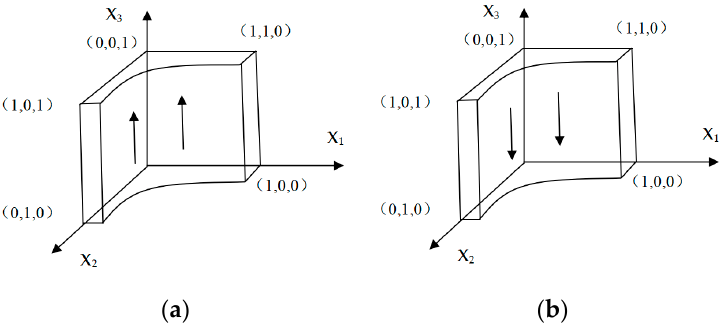
Figure 4. The evolutionary phase diagram of the e-commerce enterprise.